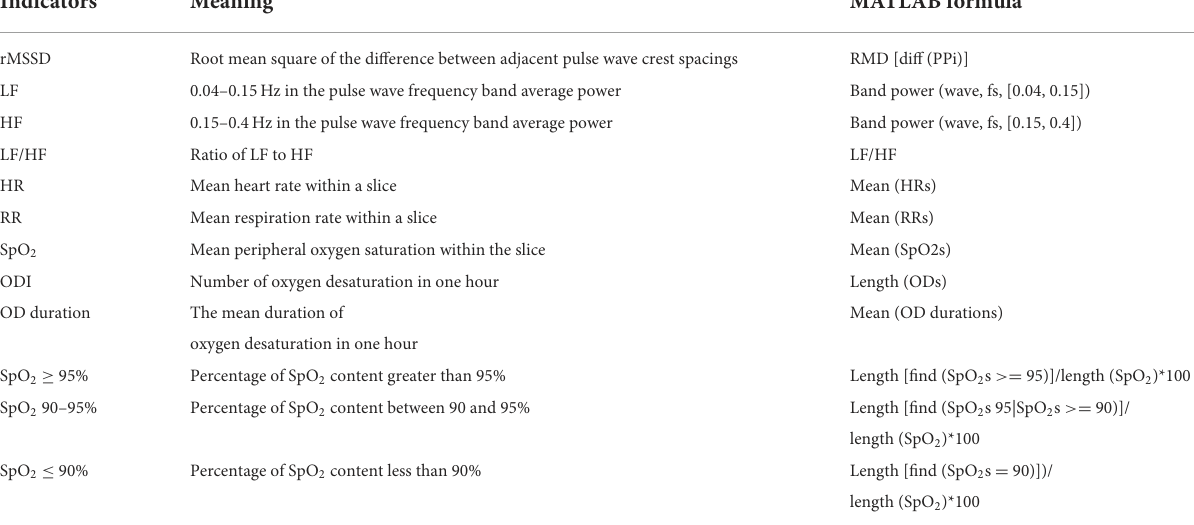
TABLE 2 Indicators of nocturnal physiological function and calculation formula. Indicators Meaning MATLAB